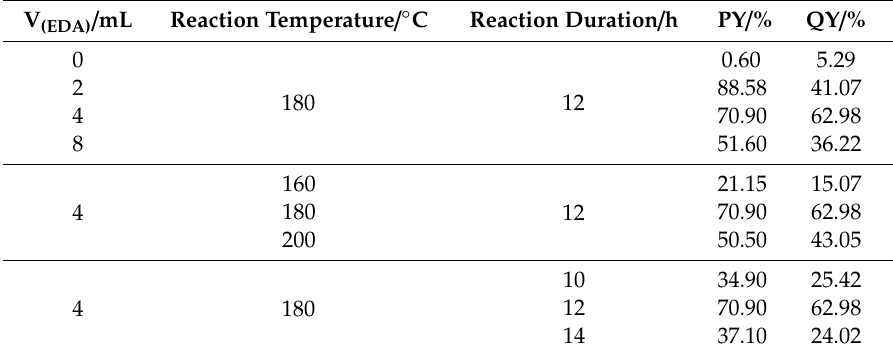
Table 1. Product yield (PY) and quantum yield (QY) values of green carbon quantum dots (g-CQDs) under di ff erent reaction